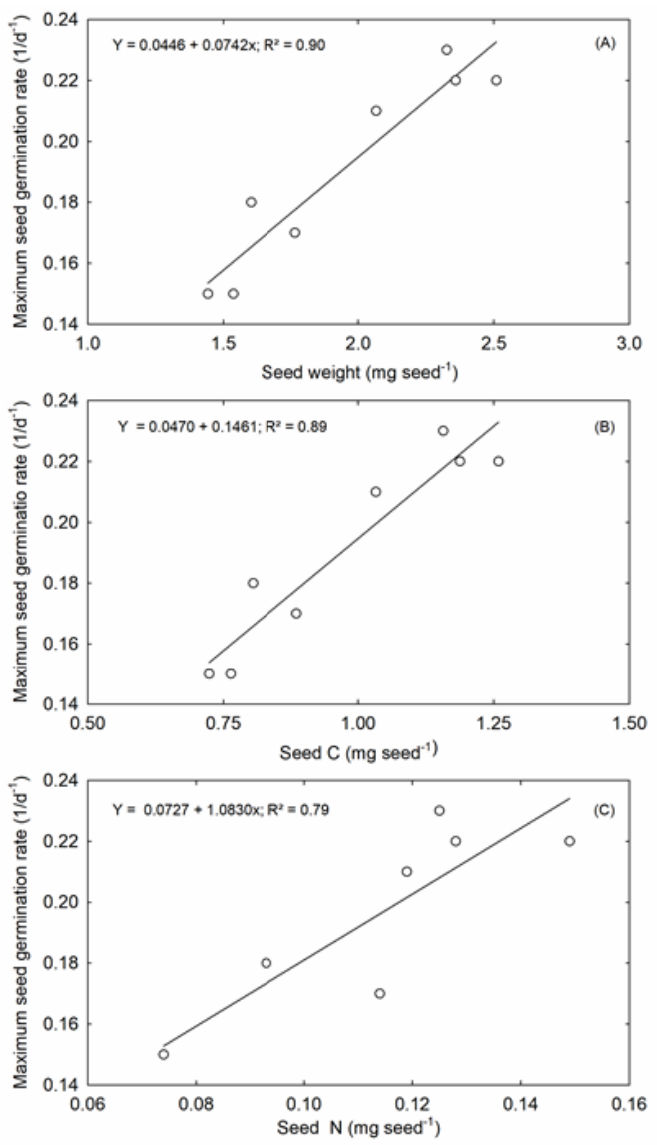
Figure 7. The relationship between seed germination rate and ( A ) seed weight, ( B ) seed C content, and ( C ) seed N content across eight parental environments. Data are means ± SE of three plants ( n = 3) harvested from a given SPAR unit and used as replicates in statistical analysis for a respective parental environment.